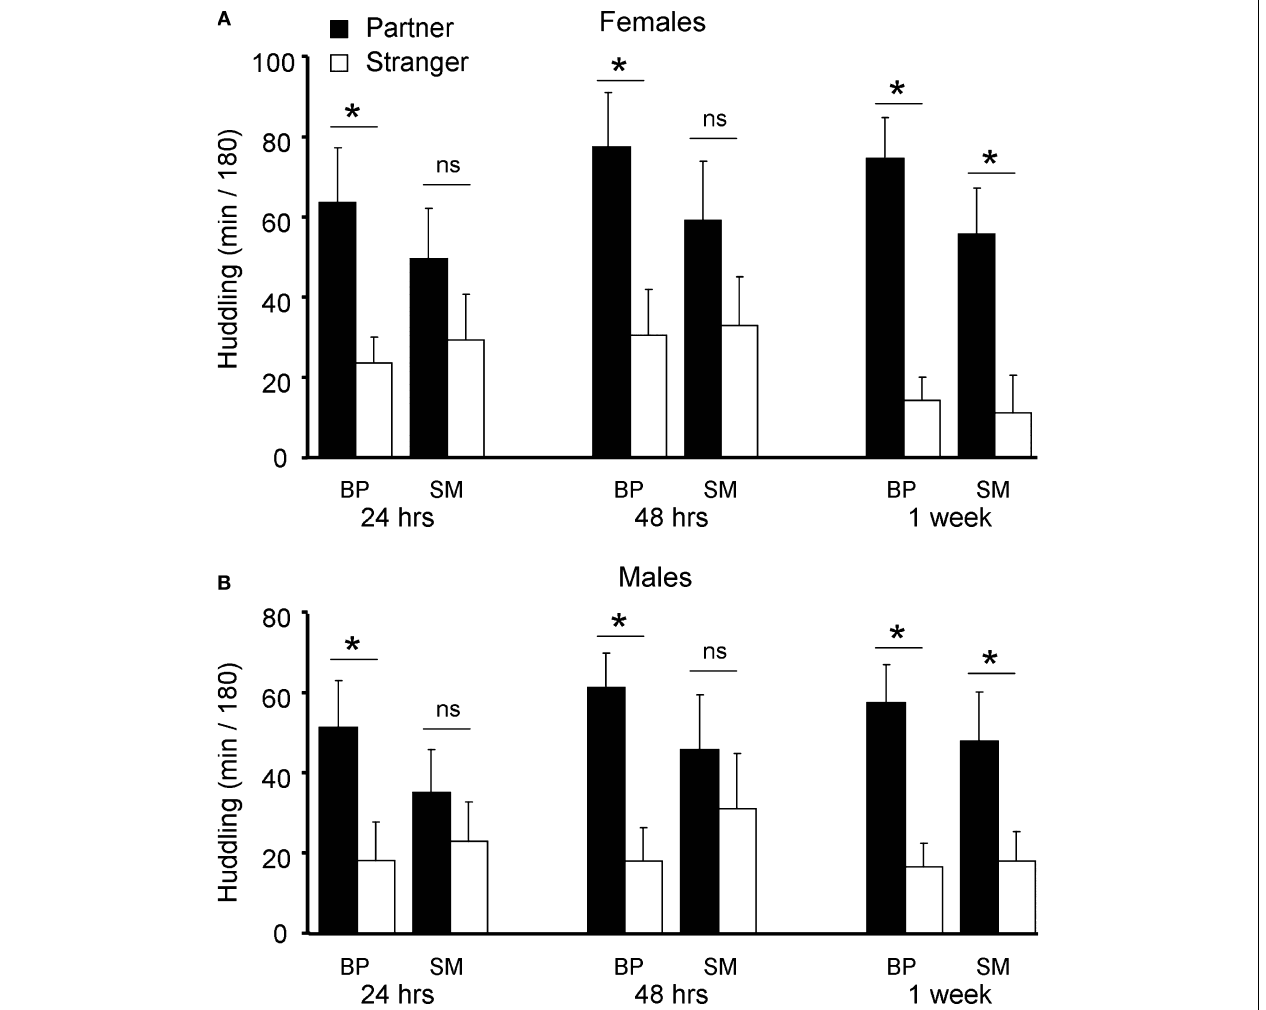
during the 1-week test. SM-reared adult males also exhibited a slower onset of partner preference formation compared BP-reared adult males (B) , again, with BP-reared males showing signifi cant group partner preferences during all three time points, while SM-reared males demonstrated a signifi cant partner preference only at 1 week. Bar graphs represent means + SEM. (cid:132) , BP-reared adult offspring; (cid:133) , SM-reared adult offspring. * P < 0.05, ns = not signifi